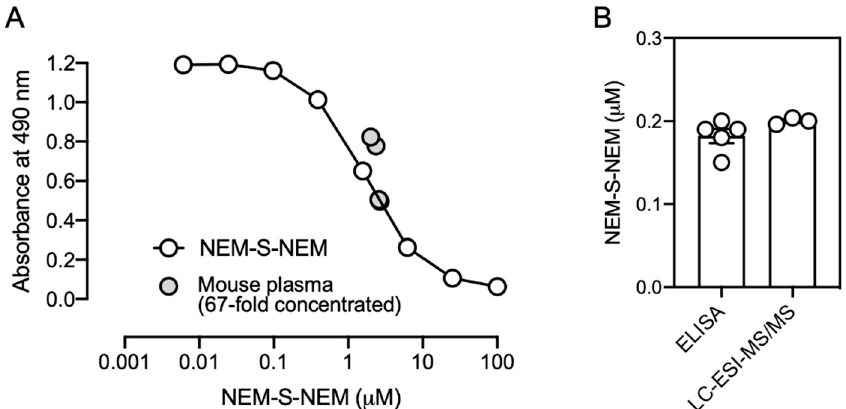
Figure 6. Detection of NEM-S-NEM in mouse plasma by competitive ELISA. ( A ) Mouse plasma was incubated in PBS containing 5 mM NEM and 50% methanol at 37 ◦ C for 1 h, and the formed NEM-S-NEM in the reaction mixture was enriched by a solid phase extraction. The eluates were dried in vacuo , dissolved in PBS, then the concentration was determined by competitive ELISA with anti-NEM-S-NEM mAb (clone 1C6). Purified NEM-S-NEM was used as a standard. ( B ) The concentration in the original mouse plasma was calculated by the following formula: the original concentration = the concentration determined by competitive ELISA (2.44 ± 0.11 µ M) × 5 (dilution factor) ÷ 67 (concentration factor). The formed NEM-S-NEM in the reaction mixture was also determined by LC-ESI-MS / MS analysis. The exact values in original mouse plasma determined by competitive ELISA and LC-ESI-MS / MS analysis are described in Supplementary Table S3.